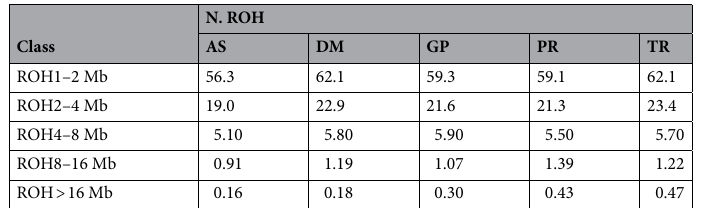
Table 2. Descriptive statistics of average number of runs of homozygosity per individual (n. ROH) by ROH length class (ROH1–2 Mb, ROH2–4 Mb, ROH4–8 Mb, ROH8–16 Mb, and ROH > 16 Mb) and per production type. AS = Asiago; DM = Drinkable Milk; GP = Grana Padano; PR = Parmigiano Reggiano; and TR = Trentingrana.